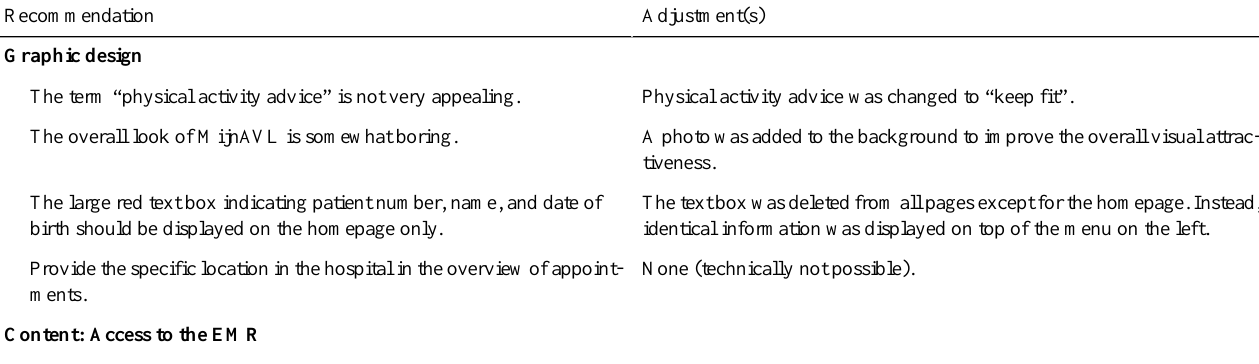
Table 1. Recommendations and changes in portal design and content based on semistructured interviews with cancer survivors (N=16).